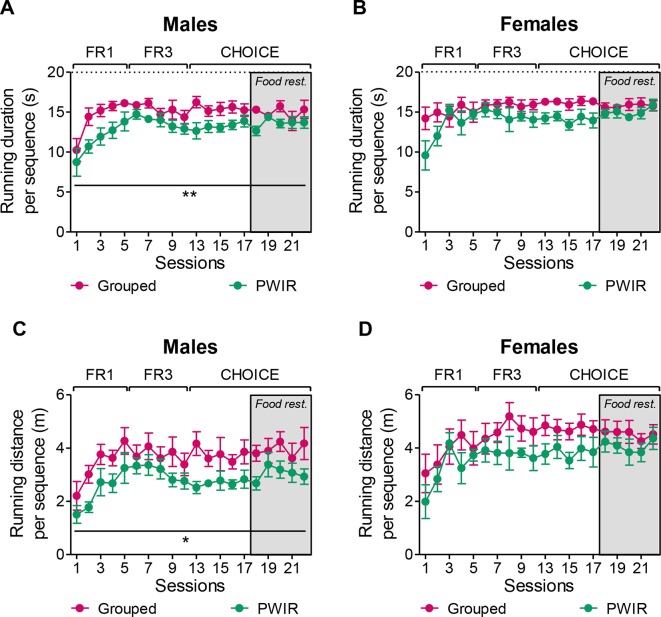
Impaired nose poke responses for wheel-running were associated with decreased running performances in PWIR males. (A,B) PWIR decreased the running duration per rewarded sequence in males (A), but not in females (B). (C,D) PWIR males (C), but not females (D), ran less distance per rewarded sequence, compared to their respective grouped controls. The values are the mean ± standard error of the mean of n = 5–6 mice. * p < 0.05 and ** p < 0.01 for the overall impacts of PWIR throughout test sessions (multiple-way analyses of variance).